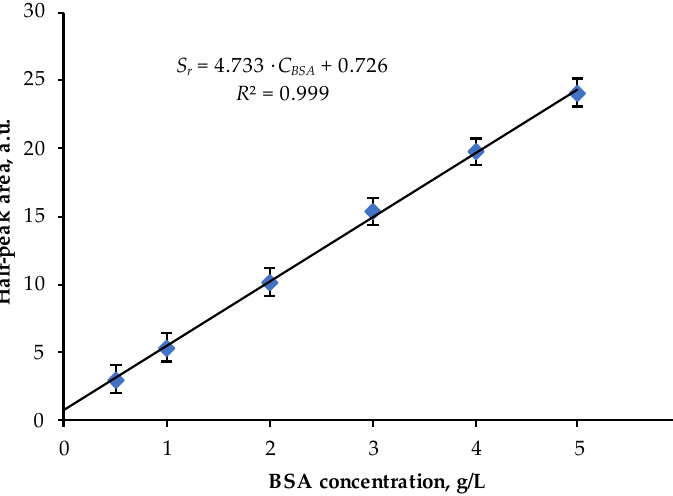
Figure 4. Dependence of the protein half-peak area on the BSA concentration.